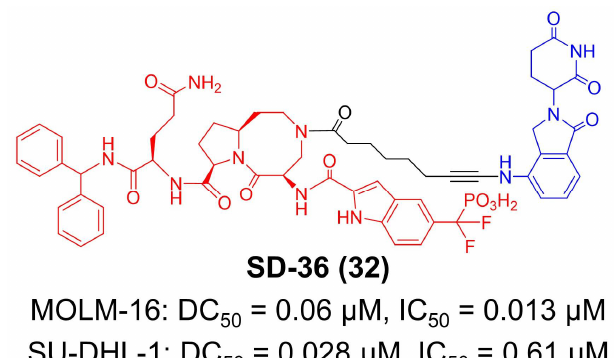
Figure 6. The chemical structure of the first PROTAC targeting STAT3. DC 50 —half-maximal degradation concentration; IC 50 —half-maximal inhibition concentration.